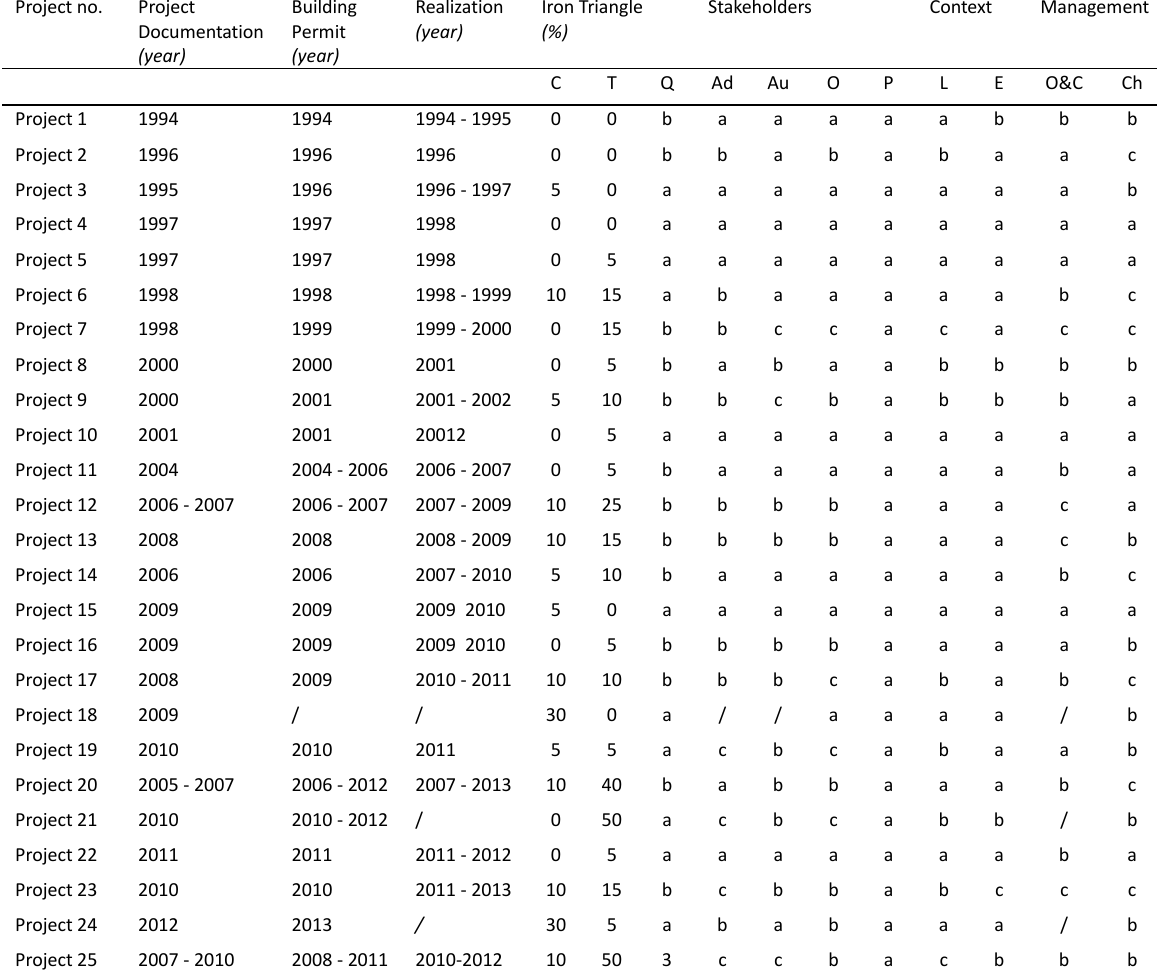
Table 1. Evaluation of individual projects (source: authors based on [5]) Project